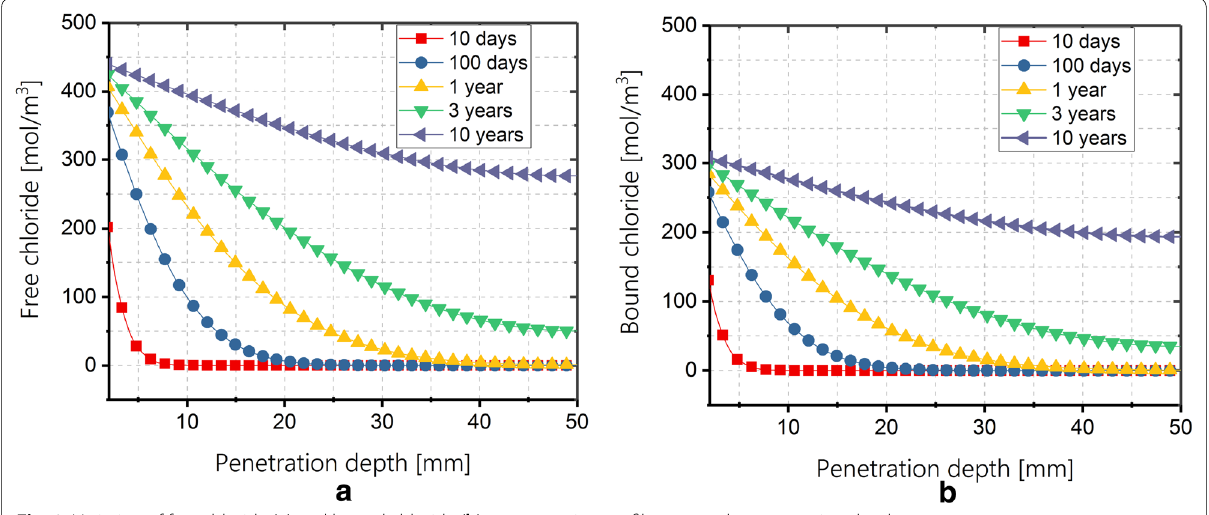
Fig. 9 Variation of free chloride ( a ) and bound chloride ( b ) concentration profiles across the penetration